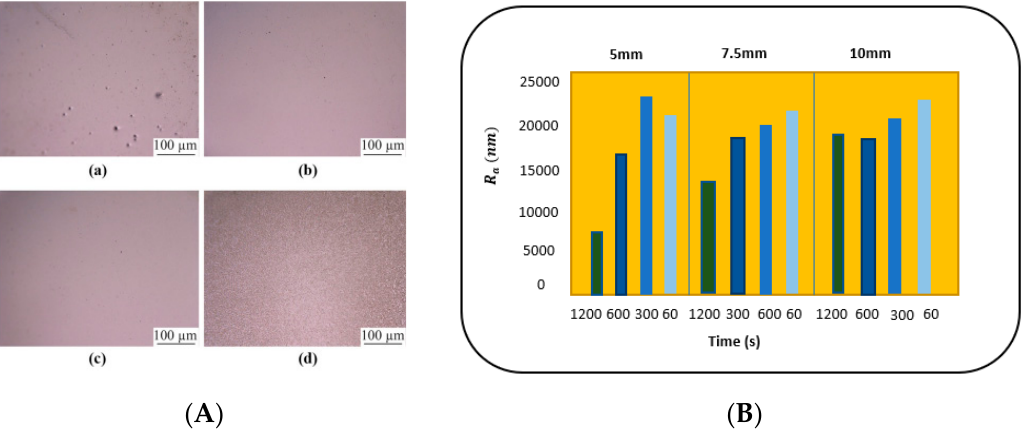
Figure 19. ( A ) Electropolishing of W in environmentally friendly NaOH with electrode gaps of ( a ) 0.15 mm, ( b ) 0.5 mm, ( c ) 1.0 mm, ( d ) 1.5 mm; ( B ) Time and distance Vs roughness (Ra) plot compar- ing the impact of differing polish times and inter anode/cathode distances at constant temperature and voltage for additively manufactured Ti (after Lassell 2016) [62].